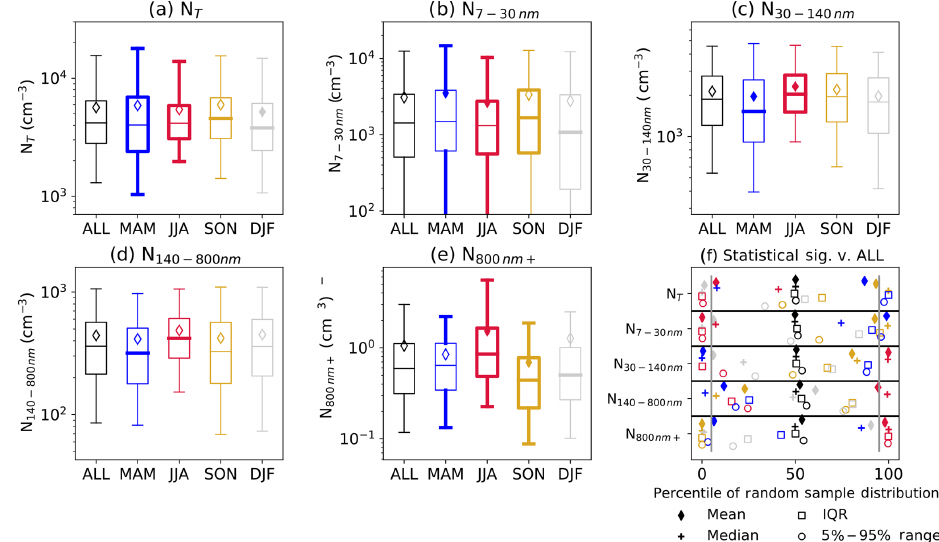
Figure 4. Distributions of integrated number concentrations for the entire size distribution (a) and for the four size ranges ( b–e , N 7 − 30nm , N 30 − 140nm , N 140 − 800nm , and N 800nm + ), shown as box-plot diagrams. Data are shown for the entire time period (ALL) and by season. The boxes represent the interquartile ranges separated into two boxes by the median values, the diamonds represent the mean values, and the lines extending from the boxes represent the 5th and 95th percentiles. Bold lines and solid symbols in panels (a) through (e) represent differences between the seasonal and ALL variables that are statistically significant at the 95% level, as described in the text and shown in panel (f) . The vertical gray lines in (f) are the 5th and 95th